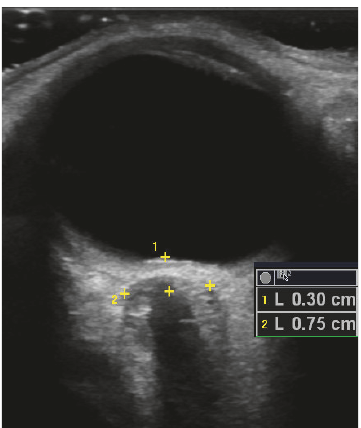
Figure 1: Showing an ultrasound scan with an ONSD of 7.5 mm measured 3mm posterior to the globe.